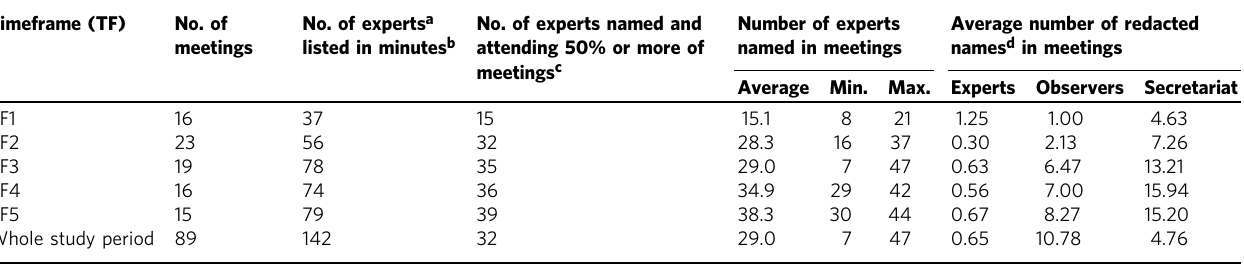
Table 2 Meeting attendance and the average number of redacted names over the study